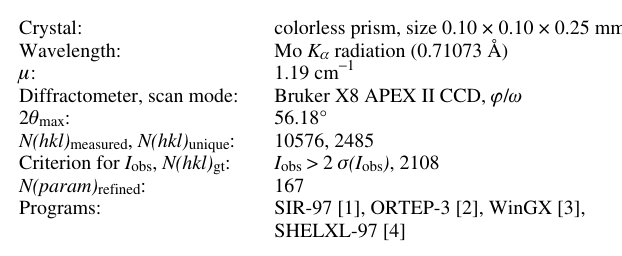
Table 1. Data collection and handling.